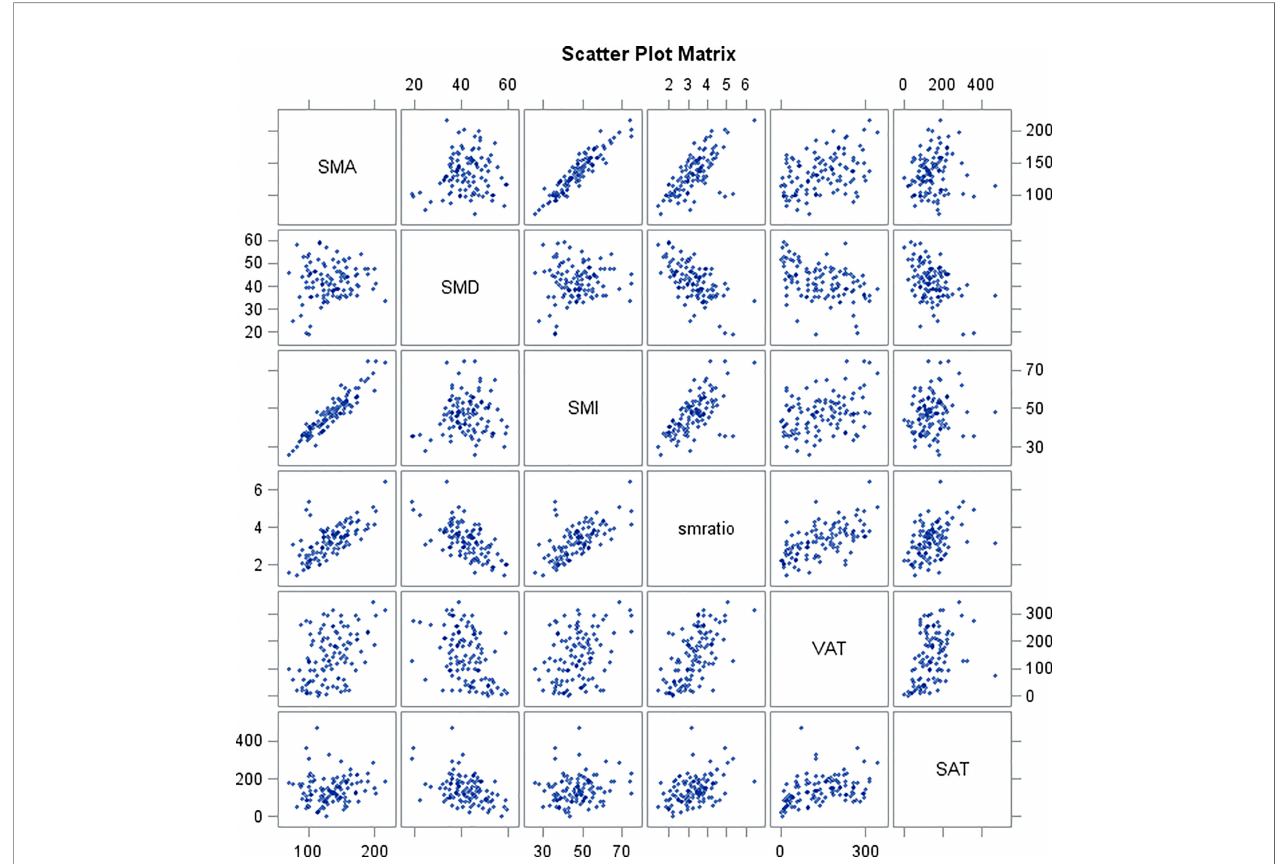
FIGURE 2 | Scatterplot matrix of skeletal muscle and adipose tissue